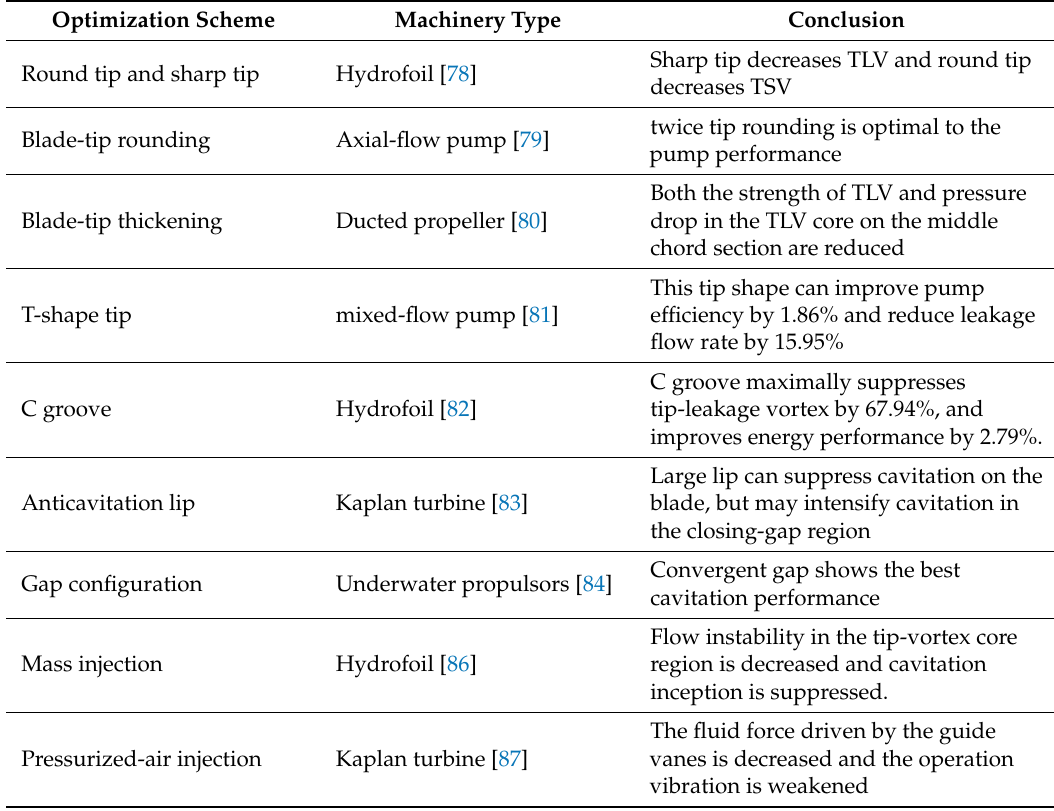
Table 5. Optimization strategies and corresponding optimization